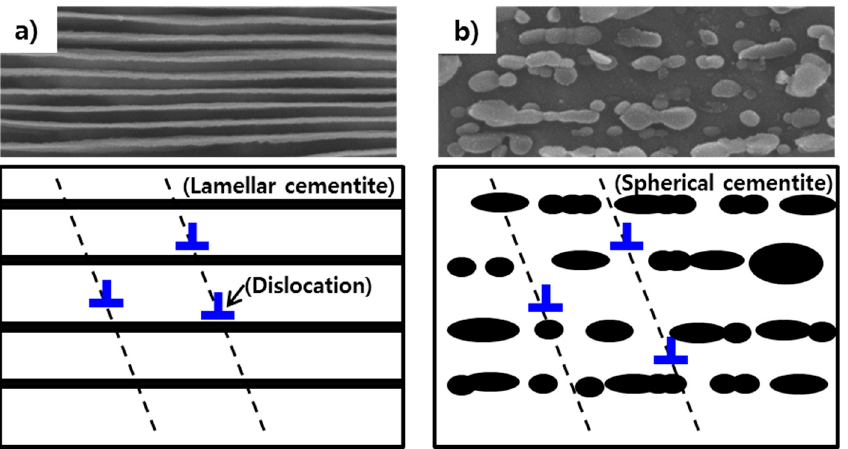
Figure 8. A schematic diagram of MPF difference due to annealing of cold drawn steel wires; (a) as Figure8. AschematicdiagramofMPFdi ff erenceduetoannealingofcolddrawnsteelwires; ( a )asdrawn drawn with a strain of 1.95, (b) annealed at 500 °C for 1 h. with a strain of 1.95, ( b ) annealed at 500 ◦ C for 1